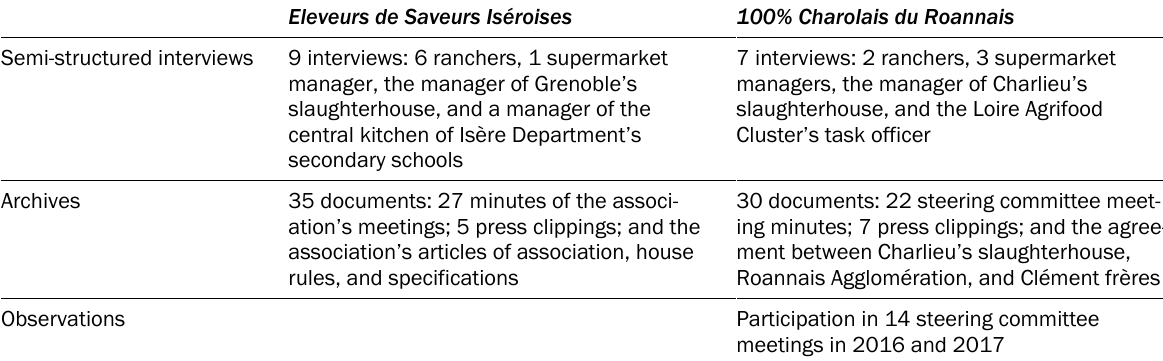
Table 1. Summary of the Field Data Used